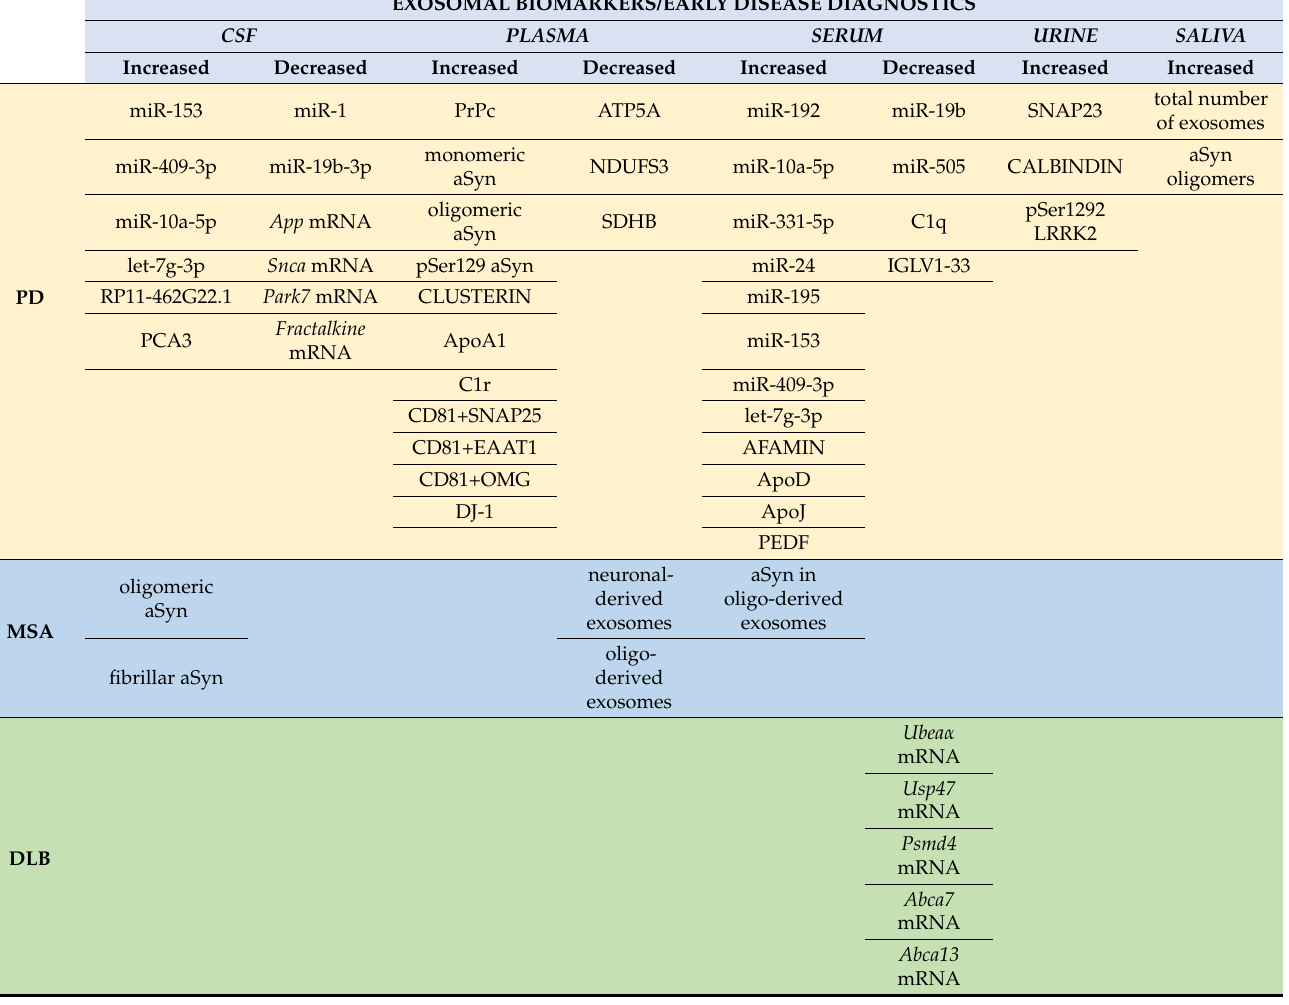
Table 1. Differential expression of various exosome-associated molecules reported in alpha- Synucleinopathies and their potential role in early disease diagnostics. A table containing the protein, mRNA and miRNA cargoes that are found either increased or decreased within exosomes derived from cerebrospinal fluid (CSF), plasma, serum, urine or saliva of PD-, MSA- or DLB-patients. EXOSOMAL BIOMARKERS/EARLY DISEASE DIAGNOSTICS CSF PLASMA SERUM URINE